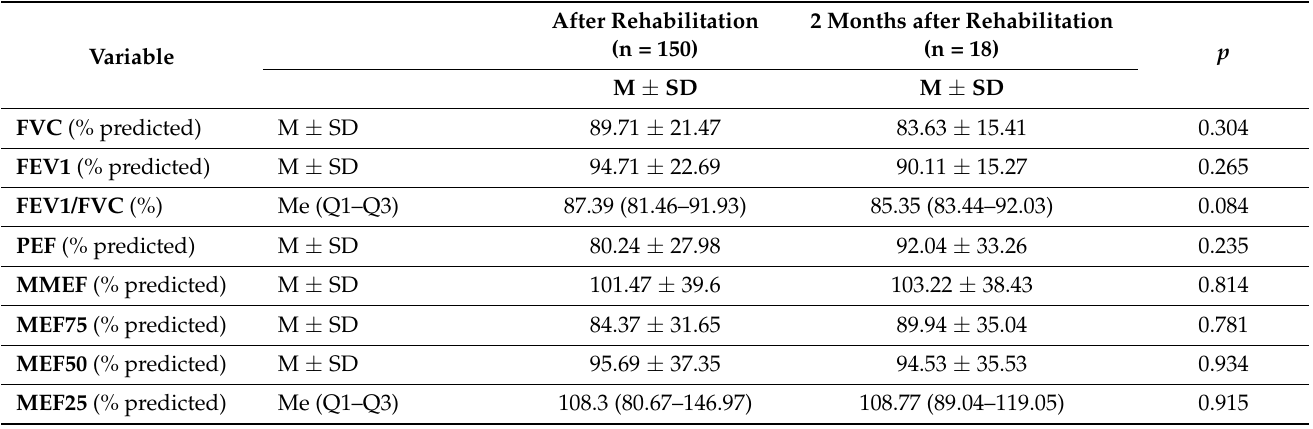
Table 4. Relationships between spirometric results after and 2 months after rehabilitation.